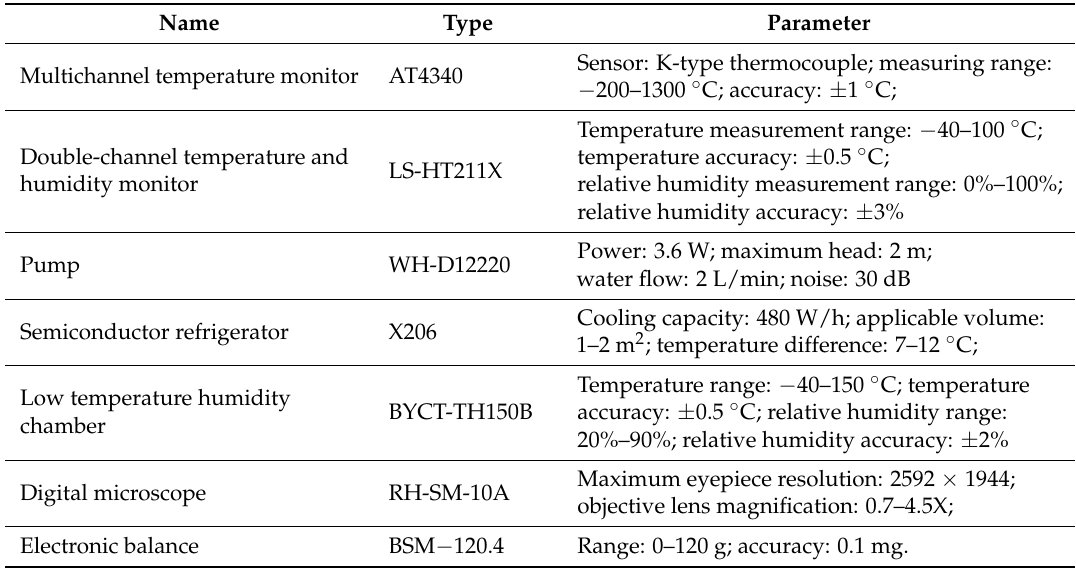
Table 2. The parameters of the experimental equipment